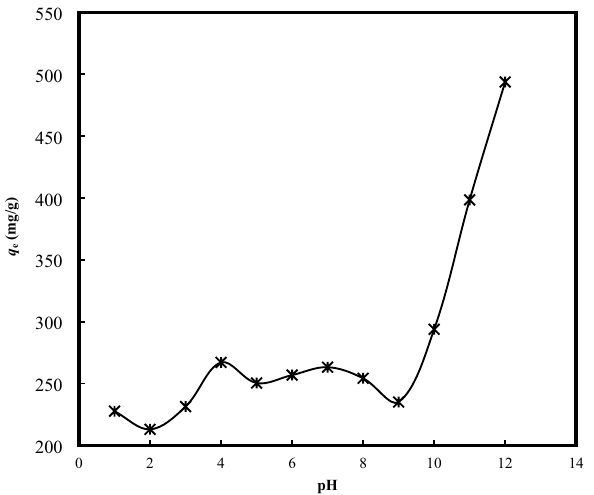
Figure 3. Effect of solution pH on the adsorptive uptake of MB onto BB (Adsorbent dosage = 0.2 g/200 mL; Temperature = 30 °C; Initial concentration = 500